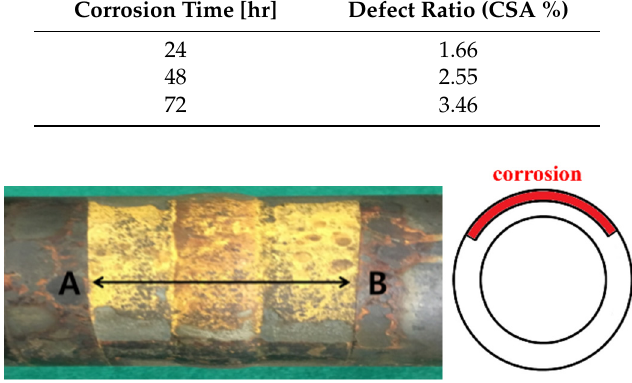
Figure 8. Pipe surface after corrosion ( left ) and diagram of cross-sectional area loss ( right ).